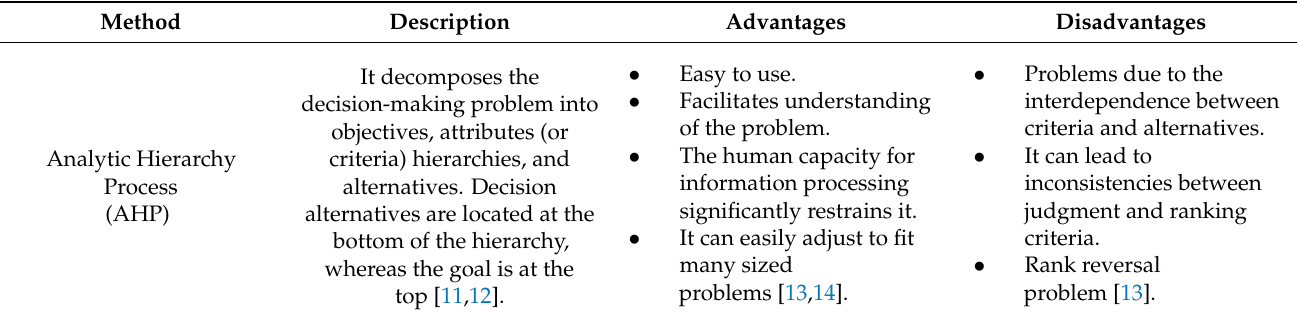
Table 1. MADM methods used in the renewable energy